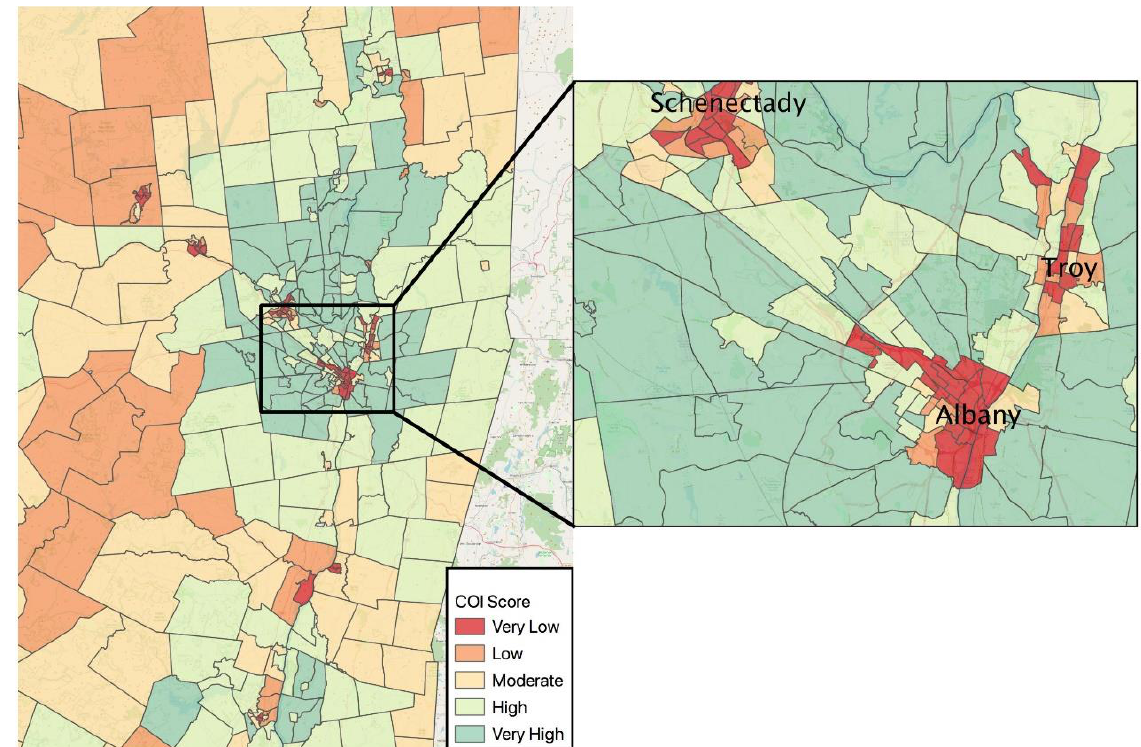
Figure 1. Maps of Child Opportunity Index (COI) scores by Census tract for the New York State Capital District. The left map includes the urban, suburban, and rural areas participants inhabited during pregnancy, as well as neighboring census tracts. All regional tracts were included so as to protect confidentiality of participants as some tracts included less than five people. Very low COI scores were heavily concentrated in urban areas, with low and moderate COI in surrounding rural regions, and very high COI concentrated in the suburbs of urban centers. The right map zooms in on the urban center of the Capital District, which encompasses the cities of Albany, Schenectady, and Troy, which is where the majority of participants lived. Table 2. Adjusted associations between neighborhood level child opportunity and birth outcomes. Full Sample Male ( n = 118) Female ( n =